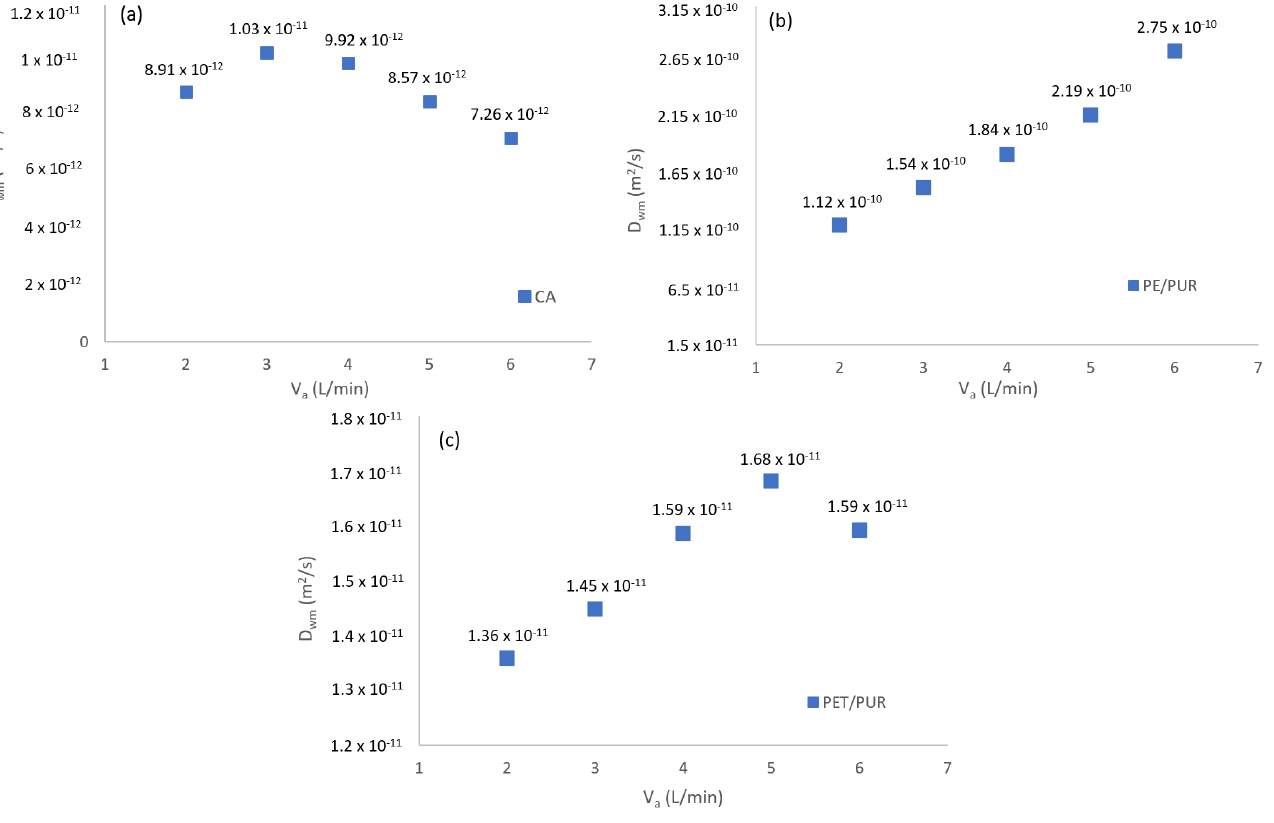
Figure 10. Diffusivities of various membranes: ( a ) CA, ( b ) PE/PUR, ( c ) PET/PUR. The calculated mean values of the moisture diffusivities in the membranes were 6.55 × 10 − 8 kg/m · s and 8.99 × 10 − 12 m 2 /s for the CA membrane, 5.82 × 10 − 8 kg/m · s and 1.9 × 10 − 10 m 2 /s for the PE/PUR membrane, and 8.54 × 10 − 9 kg/m · s and 1.53 × 10 − 11 m 2 /s for the